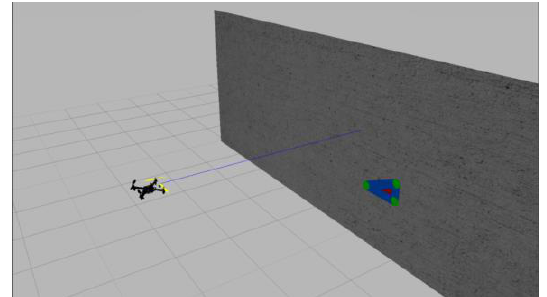
Figure 4. Quadcopter UAV model in a simple environment.